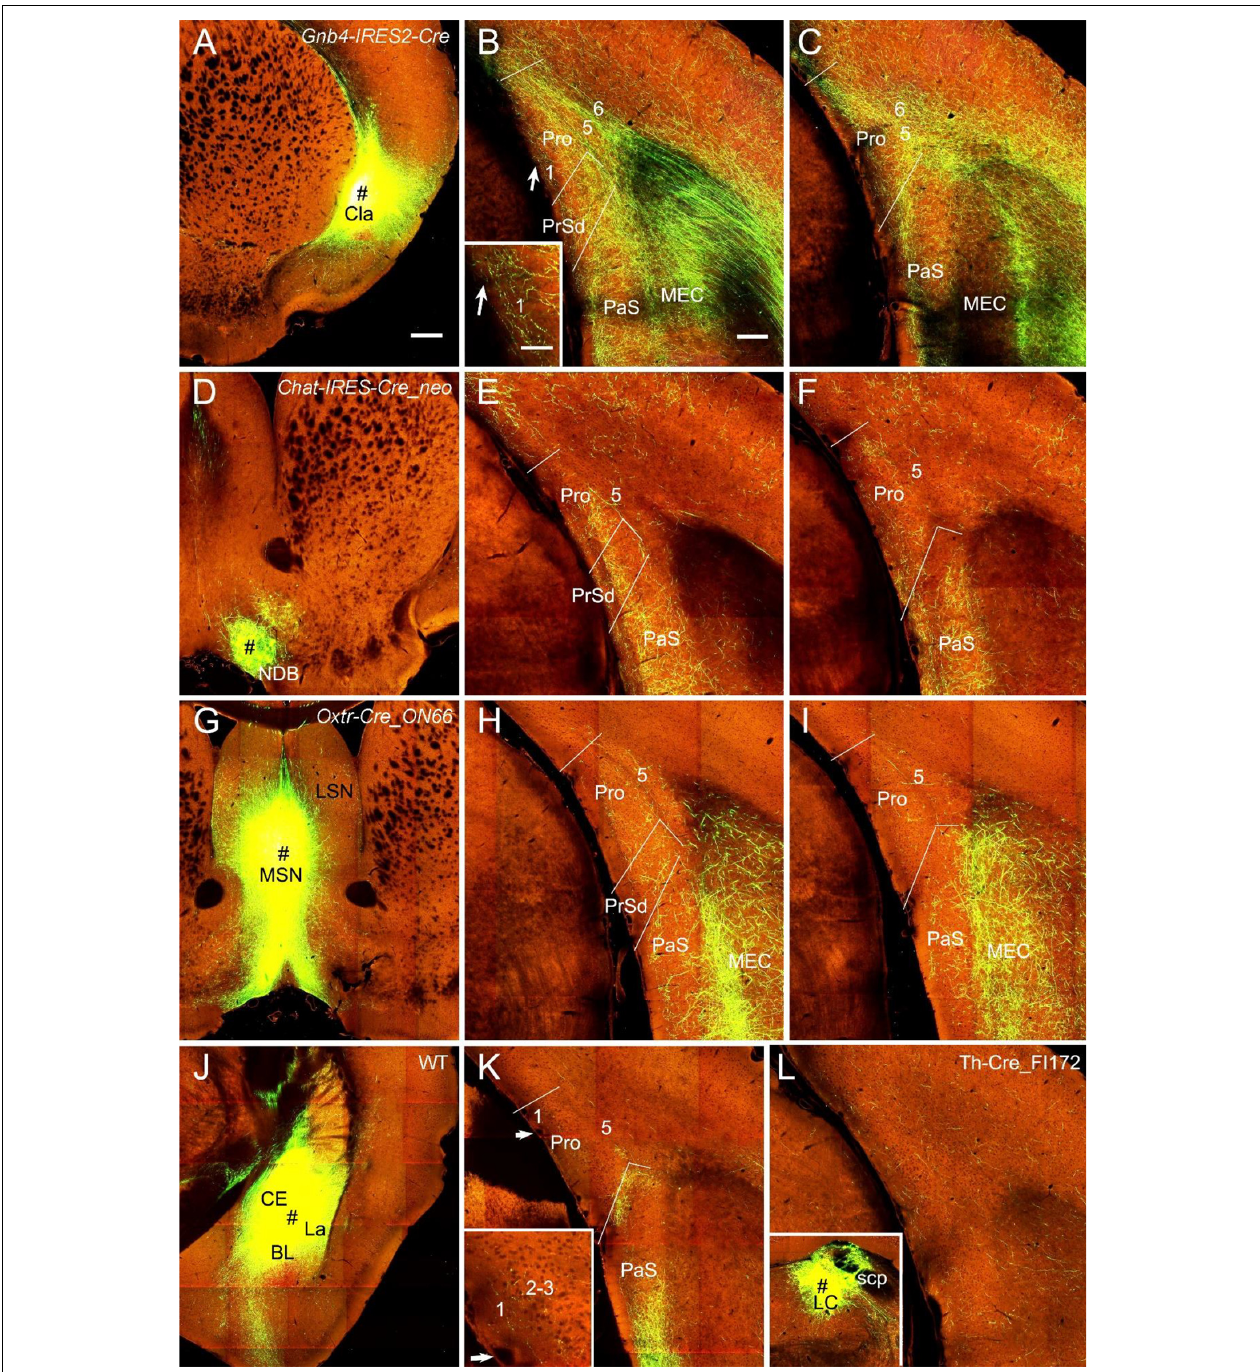
FIGURE 9 | Projections from subcortical regions to the Pro. (A–C) An injection in the claustrum (Cla) of Gnb4 -IRES-Cre mouse (Cre expression in Cla) results in obvious labeling in all layers of the Pro and adjoining regions. Moderate terminal labeling in L1–3 and strong labeling in L5–6 of the Pro is observed (B,C) . The labeling in L1 of the Pro in (B) is magnified in the inset. (D–F) An injection in the nucleus of diagonal band (NDB; # in D ) of a Chat -IRES-Cre_neo mouse (Cre in NDB) yields terminal labeling in L1–3 of the Pro with less in L5–6 (E,F) . Stronger labeling is seen in PaS. (G–I) An injection in medial septal nucleus (MSN; # in G ) of an Oxtr -Cre_ON66 mouse (Cre in MSN) gives rise to weak terminal labeling in L2–5 of the Pro (H,I) . Note the relatively stronger labeling in PrSd and PaS and the very strong labeling in the medial portion of the MEC. (J,K) An injection in the amygdalar region (CE, BL, and La; # in J ) of a WT mouse results in weak terminal labeling in L1–3 of the Pro (K) . The Pro labeling in (K) is magnified in the inset. Injections restricted in the central nucleus (CE) or basolateral nucleus (BL) yields no labeling in the Pro (not shown). (L) Weak terminal labeling in L1–6 of the Pro after an injection was placed in locus coeruleus (LC) of a Th-Cre_FI172 mouse (# in the inset in L ). Bars: 350 µ m in (A) (for A , D , G , J , and inset in L ); 200 µ m in (B) (for other panels); 70 µ m in the inset in (B) (also for the inset in K ).